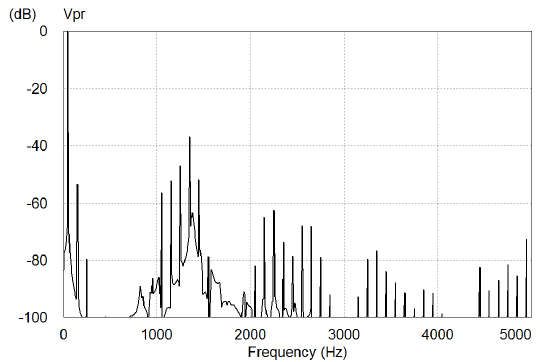
Figure 15. Steady-state primary (catenary) voltage (Vpr) under current unbalance in the different converters.